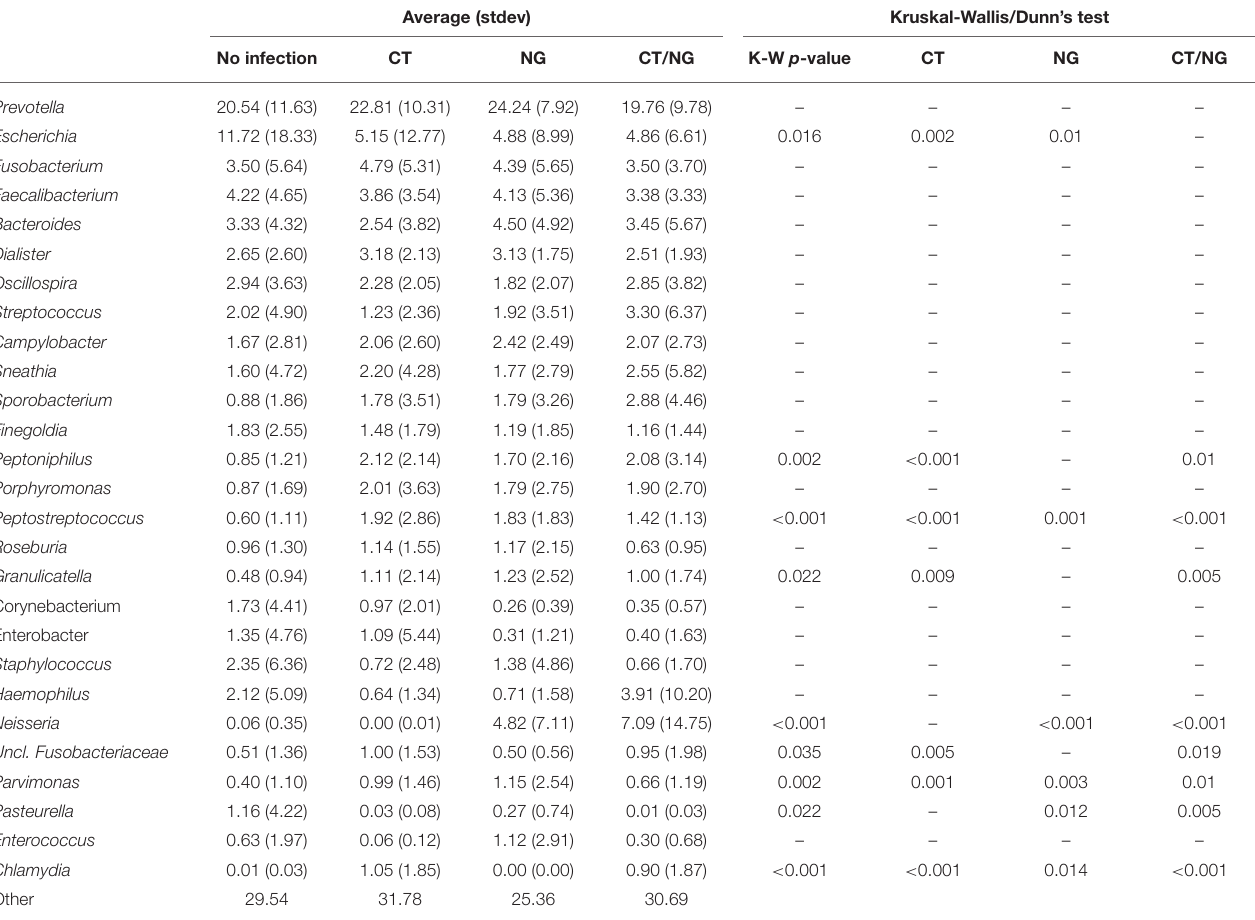
TABLE 2 | Average relative abundance of main microbial